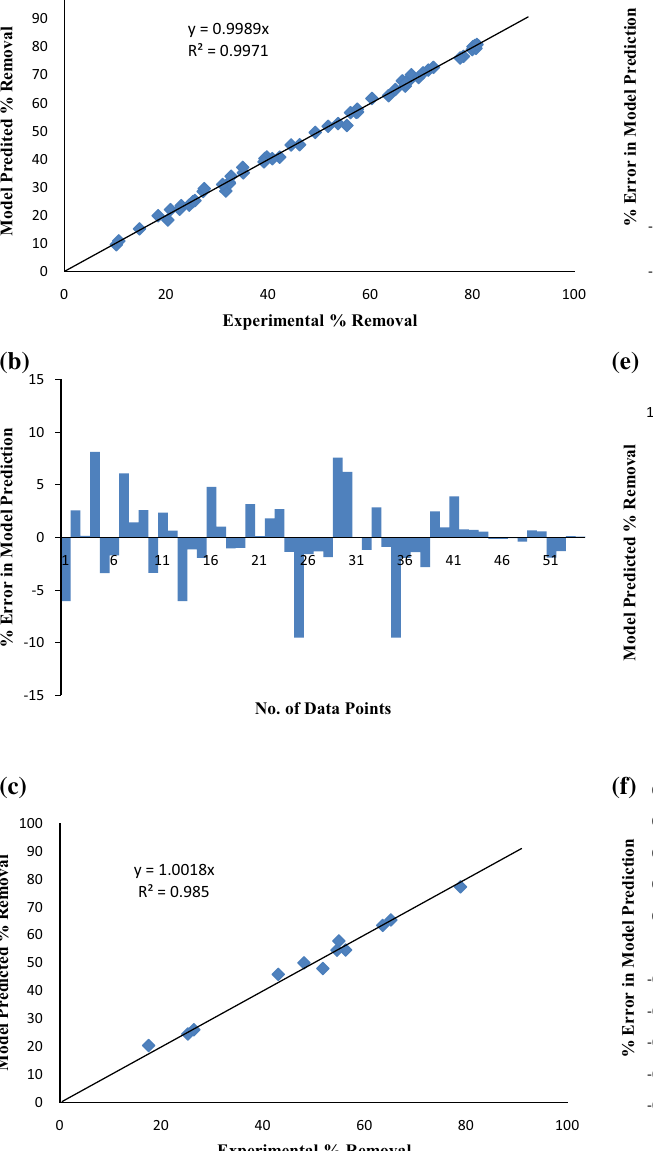
Fig. 11 a Comparison of ANN prediction for training data set (54 points), b percentage error in ANN prediction for training data set (54 points), c comparison of ANN prediction for validation data set (12 points), d percentage error in ANN prediction for validation data set